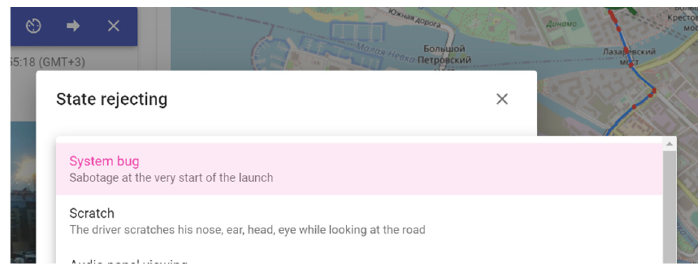
Figure 6. Screenshot example: rejecting of the detected threat by a dispatcher.